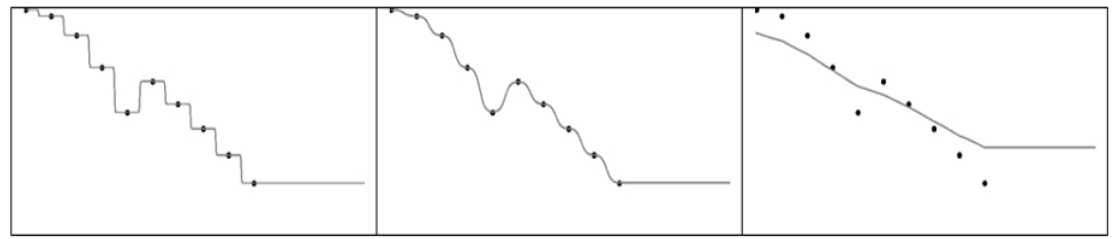
when: a) α = 20; b) α = 2. 1